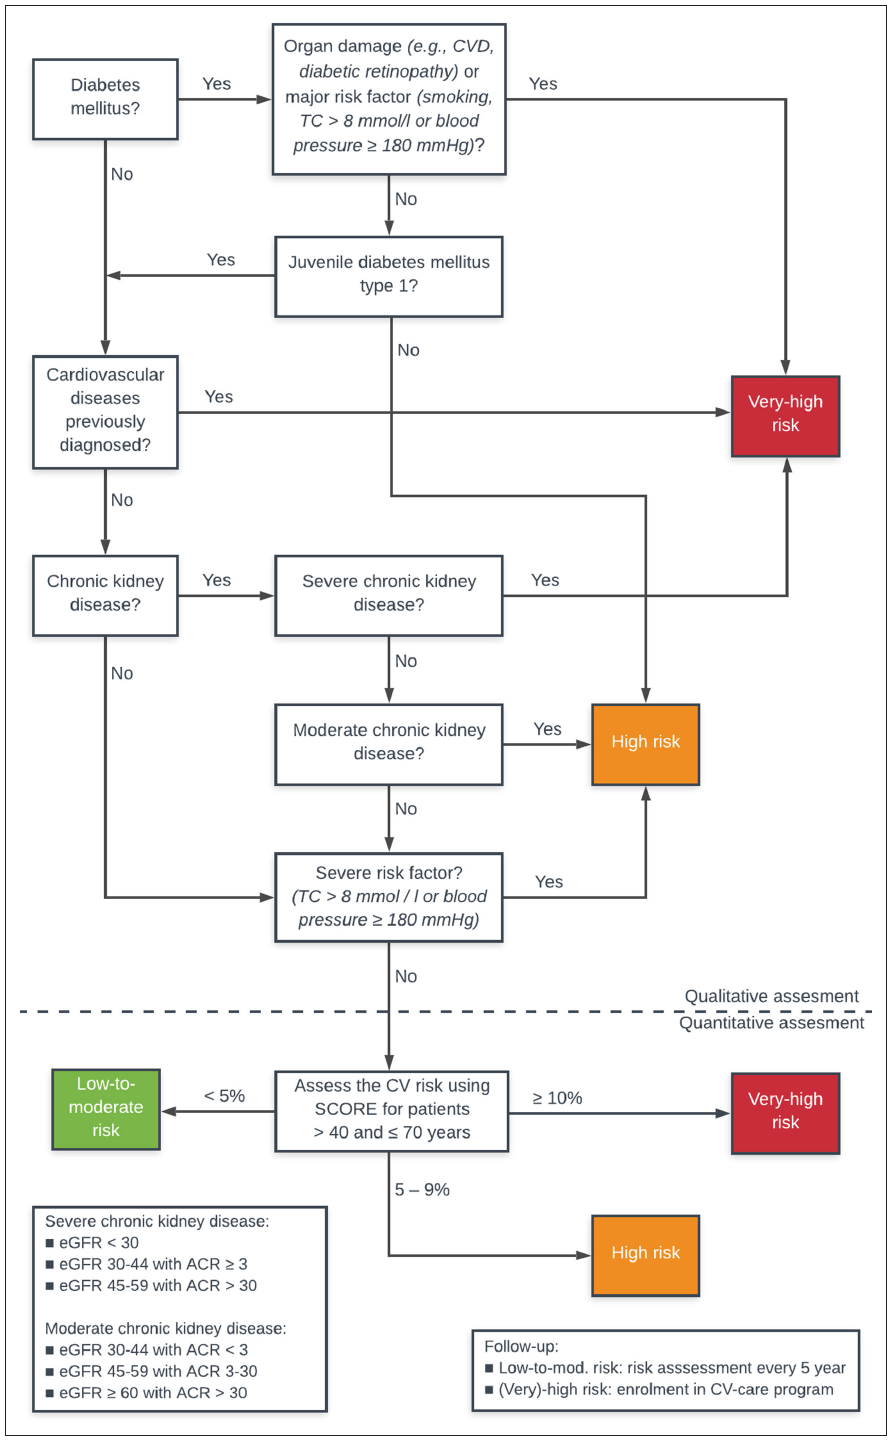
Figure 1 Flowchart risk categories (Dutch CVRM guideline). 8,26 ACR = albumin- creatinine ratio in urine. CV = cardiovascular. CVD = cardiovascular disease. eGFR = estimated glomerular filtration rate. SCORE = Systematic Coronary Risk Evaluation. TC = total